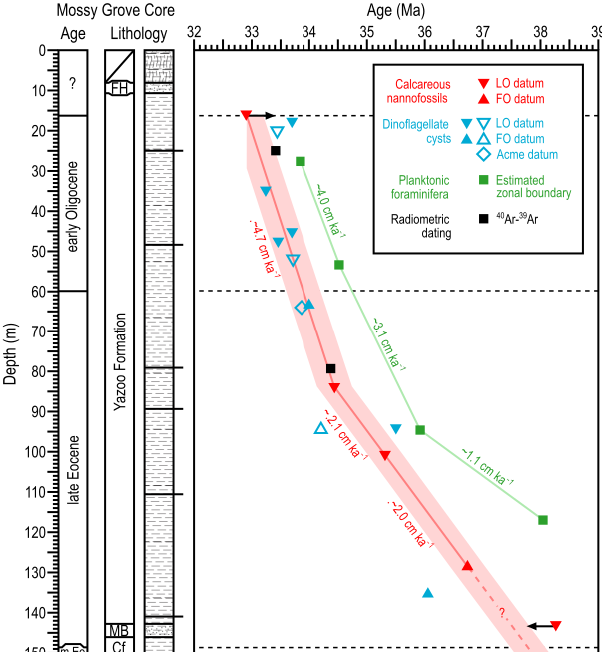
Figure 5. Refined age–depth model of the Mossy Grove core. Lithology follows Dockery III et al. (1991) and the timescale fol- lows Westerhold et al. (2014). Best fit lines for the models of Fluegeman et al. (2009) and this work are represented as green and red lines, respectively. Sedimentation rates are also indicated. The shaded area in light red reproduces an error of ∼ 0 . 3Myr, simulat- ing the inclusion of the stated error on radiometric dating of both bentonites. Empty markers refer to bioevents regionally correlated (see Fig.